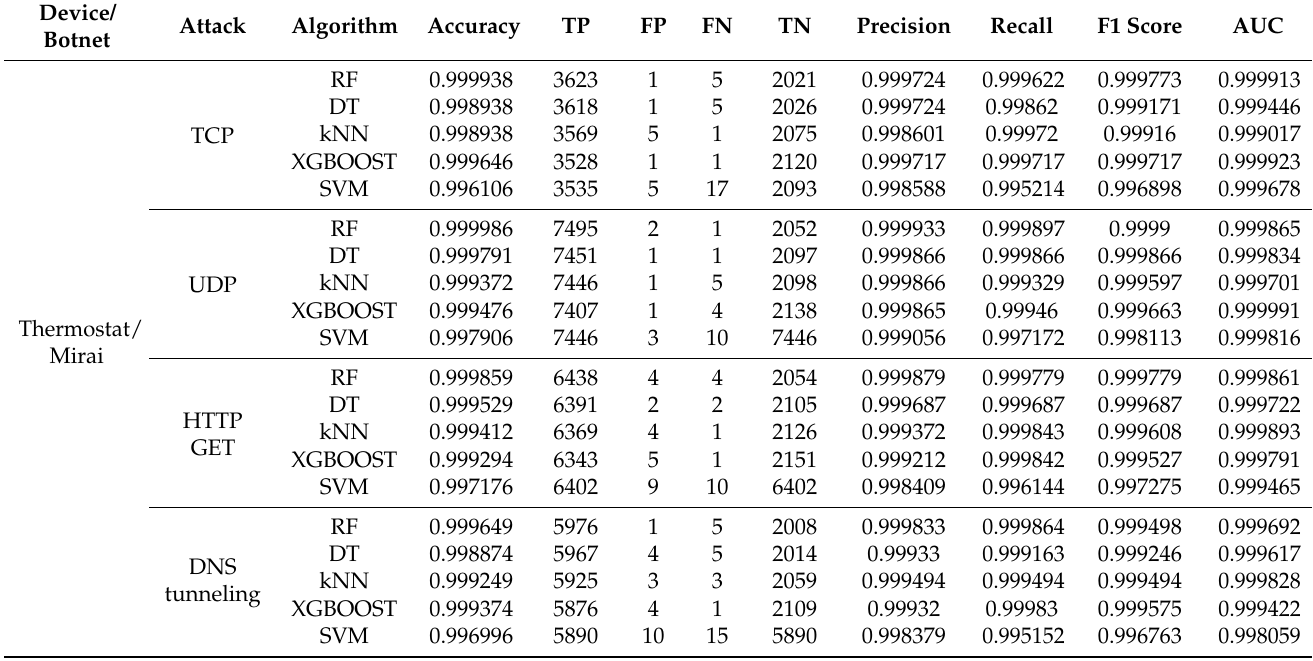
Table 14. Classification results (thermostat—Mirai).